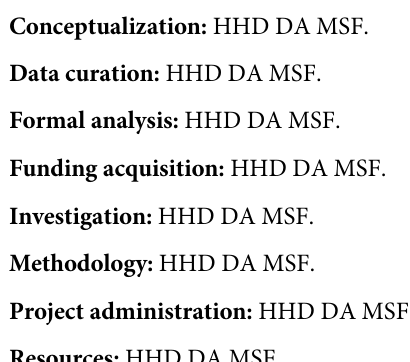
S3 Fig. Uva activity peaks prior to syllable onset and dips prior to syllable offset. Above is a spectrogram of a single motif. Red bars represent the syllable lengths, with syllable labels below. (A) ( i ) Uva activity peaks prior to syllable onset. Raster(top) represents the power of neural activity during each syllable rendition. Red line marks syllable onset and orange line marks syllable offset. Syllables are grouped based on identity, arranged from longest to shortest syllable in descending order and then aligned to syllable onset. Individual syllables have been identified and labeled. Below is a syllable onset aligned multiunit trace averaged across all sylla- bles. Also shown is the baseline activity during vocalization determined from random shuffling of multiunit activity (yellow; shading indicates 95% confidence interval for maxima and min- ima anywhere in this window). (ii) Uva activity dips prior to syllable offset. Heat raster (top) shows all syllables aligned to syllable offset. Average trace (below) shows a dip prior to syllable offset. ( B ) Data from an additional bird. (TIF) S4 Fig. Rhythmicity during long syllables. ( A ) In many long syllables ( > 150ms in length), we observed rapid oscillations in Uva activity. ( B ) In these long syllables, we consistently observed a peak in the power spectrum of Uva activity at frequencies in the gamma range. ( C ) Uva activ- ity during these long syllables is significantly coherent with song amplitude across a large fre- quency range (1-55Hz) and ( D ) across all birds when compared to null distribution (yellow), calculated from randomly shuffled neural data (see Methods) (gray shading indicates 95% con- fidence interval for maxima anywhere in this window). (TIF) S5 Fig. Uva activity is suppressed following bout offset for approximately 200ms. ( A ) A bout offset (blue) aligned multiunit trace averaged across all bouts (black). Also shown is the baseline activity during non-singing determined from random shuffling of multiunit activity (yellow; shading indicates 95% confidence interval for maxima and minima anywhere in this